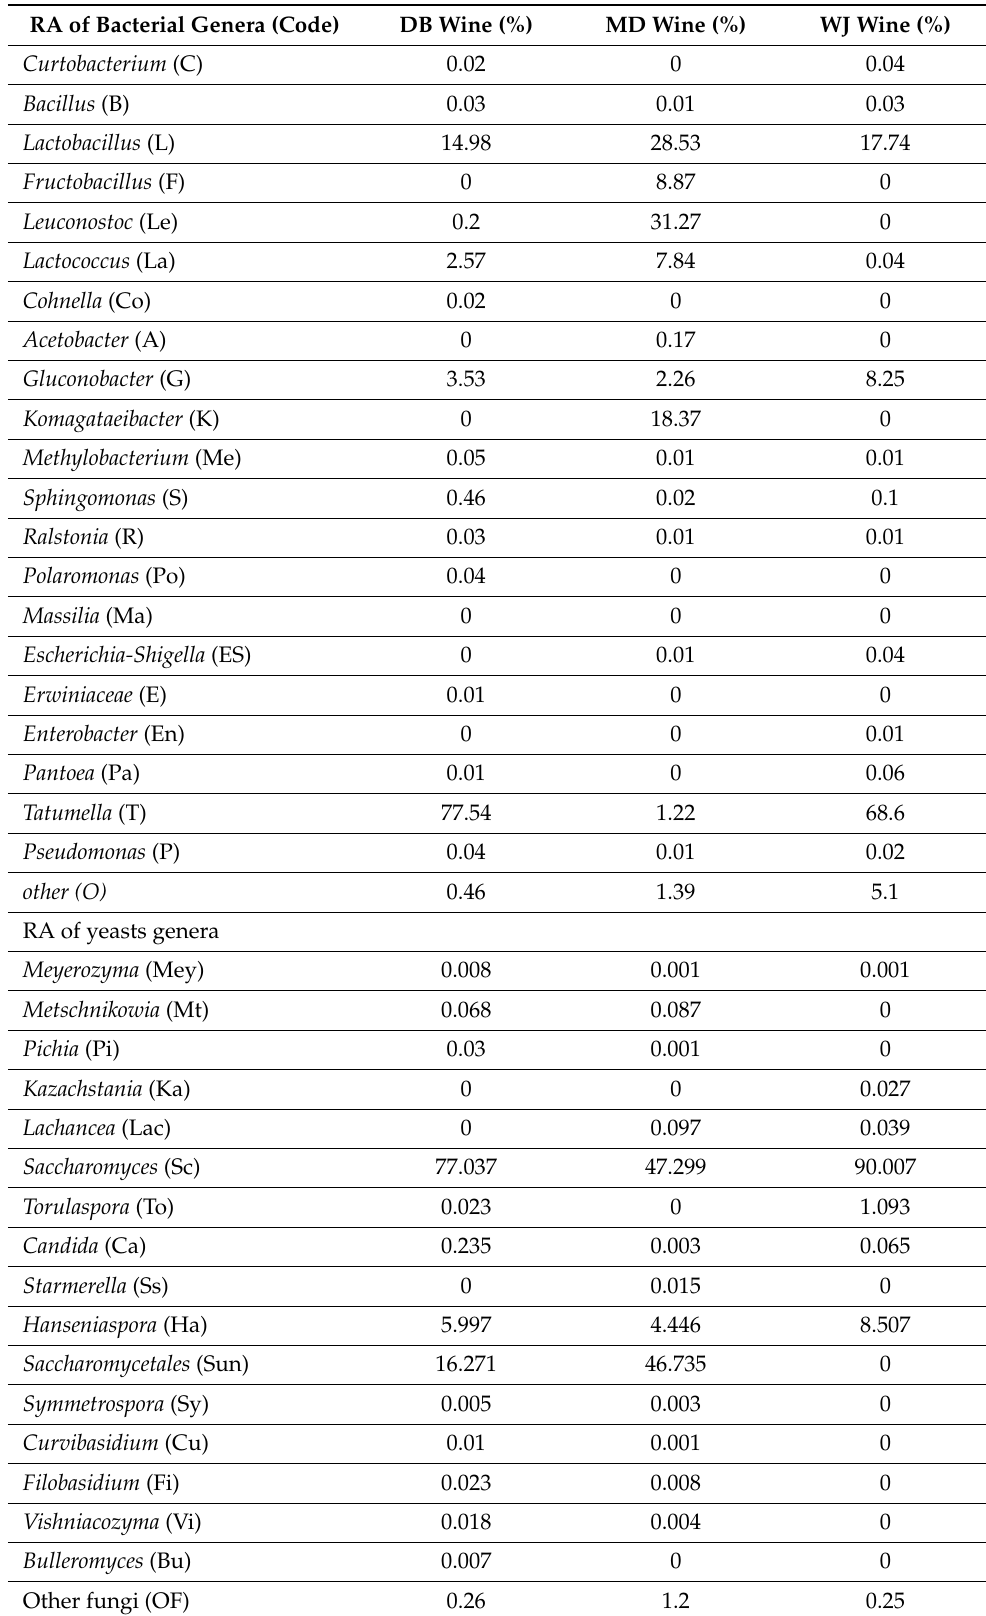
Table 2. Relative abundance (RA) of bacterial and yeast genera identified in the Polish red wines. RA of Bacterial Genera